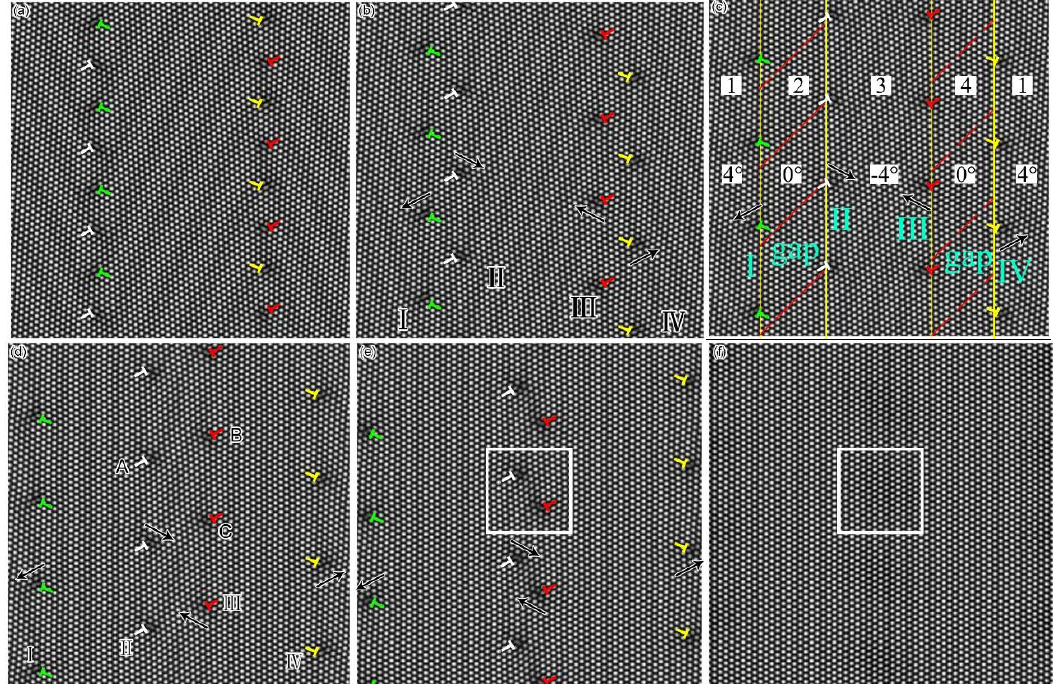
Figure 4. The snapshots of migration and annihilation of the dislocation of the SGB in sample under the applied strain. Here the vertically arranged dislocations are ignored in the present paper in order to highlight the slip motion of dislocations, which has some different from that in previous publication such as Reference [46,52,56,62]. In these figures, the arrows indicate the directions of the slip motion of the dislocations, and the gap indicates the region with red slashes between the SGBs where the deformed grain is. The numbers 1, 2, 3, 4 represent respectively four grains, and 4°, 0°, −4° represent the misorientation of the grains, respectively. White box area in the figure shows the dislocation annihilation and the generation of the complete crystal. (Although previous studies reported similar results, they did not reveal these phenomena from the dynamics of deformed grains. This is the biggest difference between the present work and the previous results [46,52])